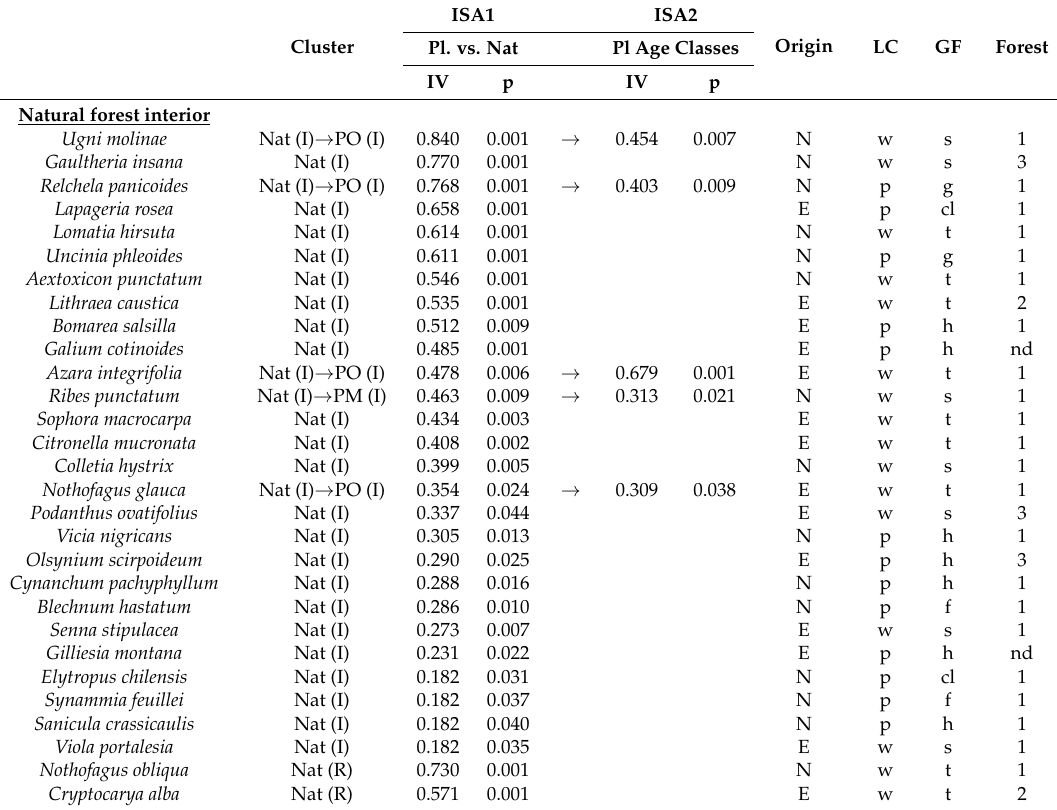
Table 2. Indicator species of forest interiors and roadsides in plantations and the natural forest. We conducted two indicator species analysis